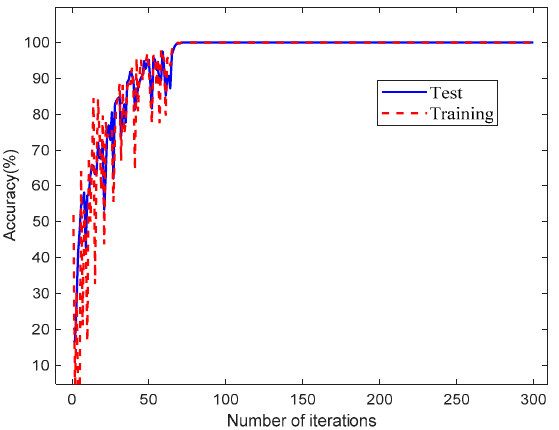
Figure 5. Accuracy curve of the fault diagnosis model based on the TSCNN.